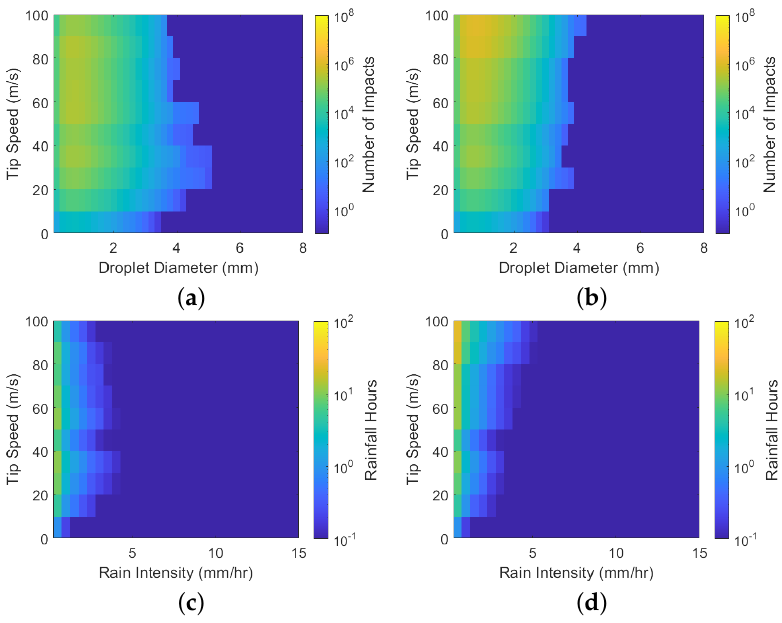
Figure 14. The average impact distributions during the months July ( a ) and December ( b ), respec- tively, for each given speed bin. ( c , d ) show the total number of rain hours for a given speed bin during the same periods.